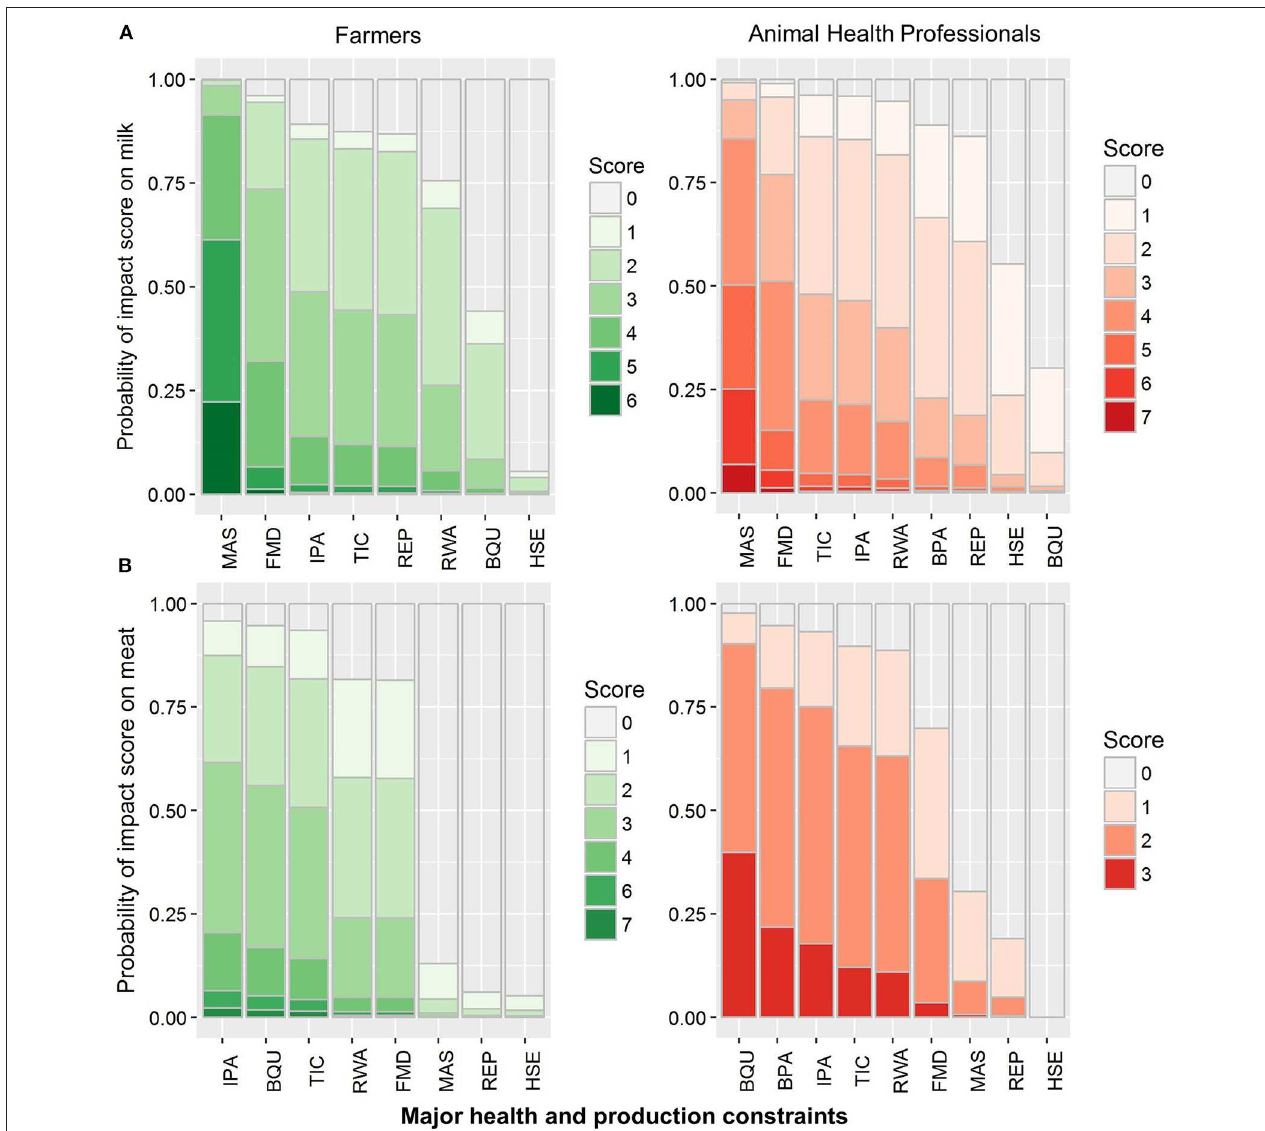
FIGURE 3 | Grouped stacked bar plot of logistic regression of probability impact score of bovine health and production constraints on milk (A) and meat (B) production in cattle and buffaloes perceived by small-scale dairy farmers and animal health professionals in Pakistan. Major bovine health and production constraints include blood parasites (BPA), blackleg (BQU), foot-and-mouth disease (FMD), hemorrhagic septicemia (HSE), internal parasites (IPA), mastitis (MAS), Redwater (RWA), reproductive disorders (REP), and ticks